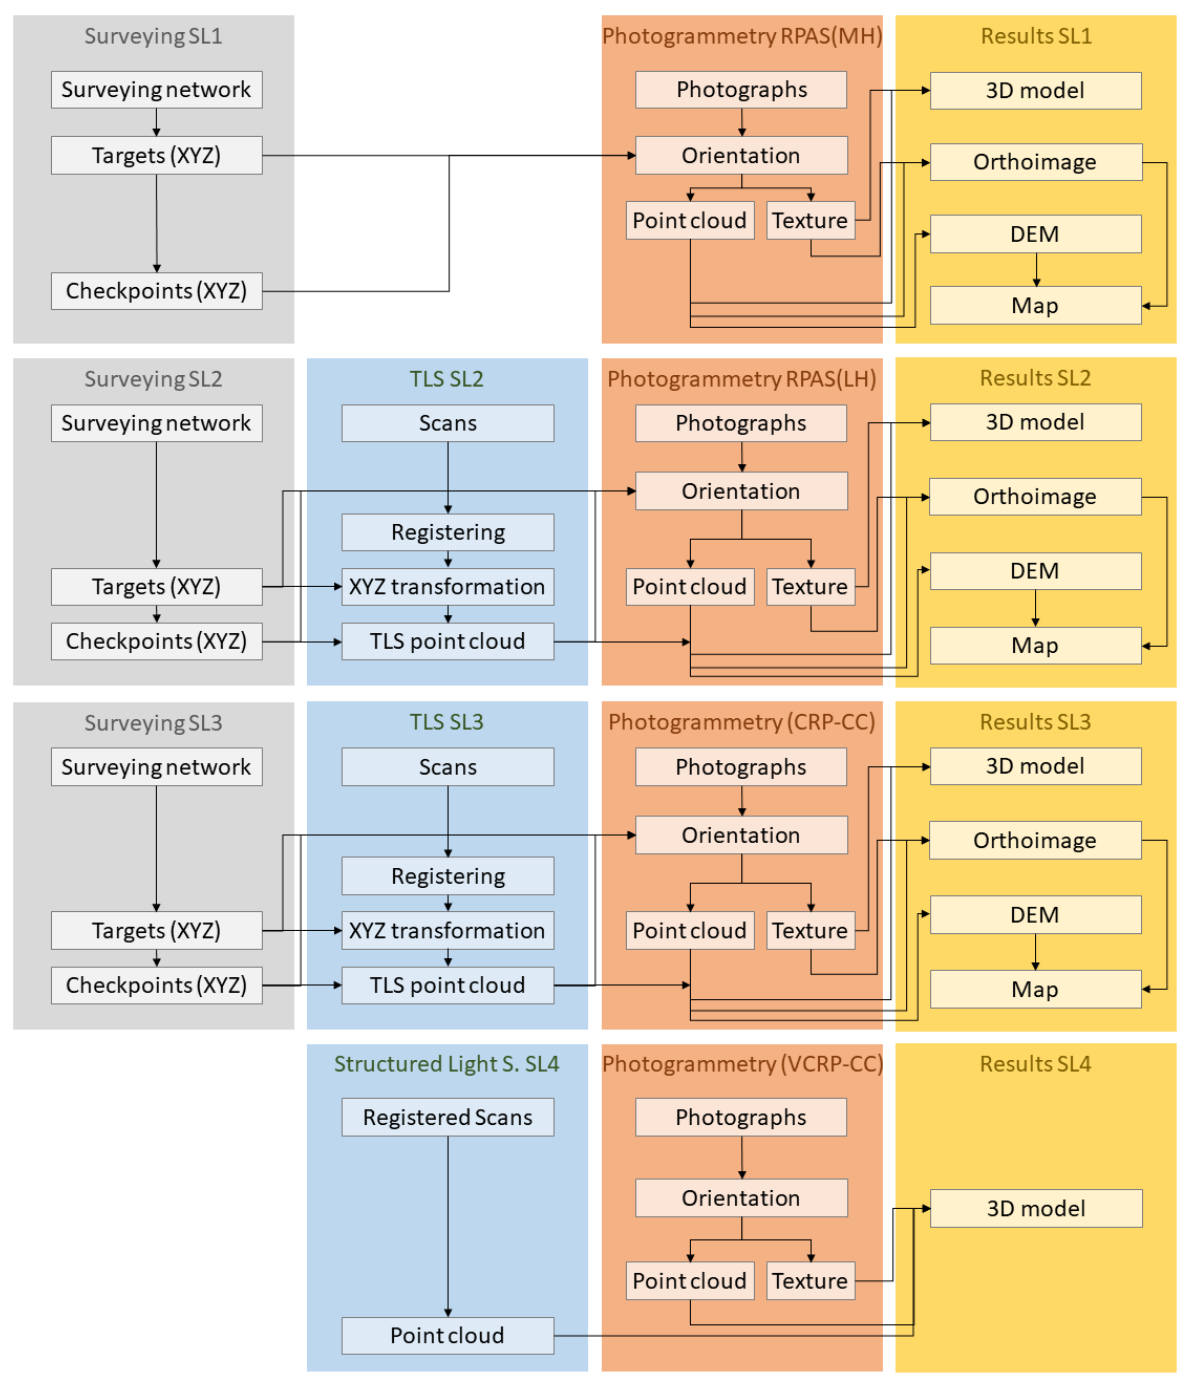
Figure 2. Workflow of the applications developed in this study, considering the scale level.